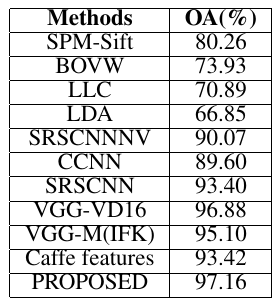
Table 2. Comparison with the previous reported accuracies